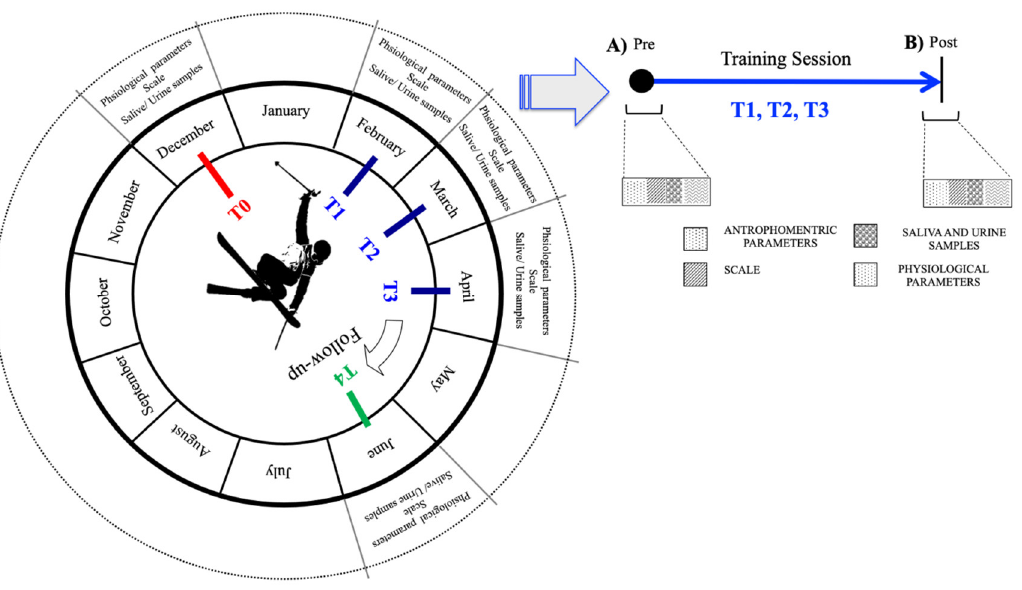
Figure 1. Study protocol design, seasonal circle, and session training. Freeskiing athletes were tested five times throughout a competitive season: at the beginning (T0); every month (T1, T2, and T3); and two months after the end of the season (T4). Furthermore, as shown in the scheme on the right of the figure, from T1 to T3, the athletes were tested pre- ( A ) and post- ( B ) training session.